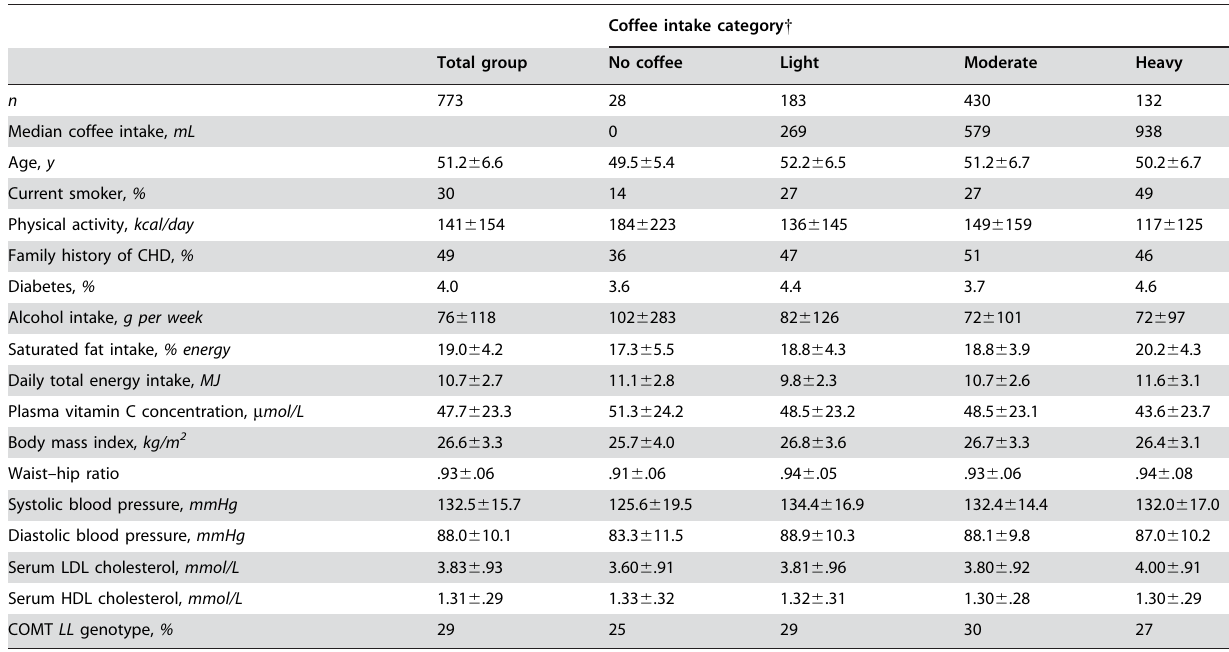
Table 1. Characteristics of the study participants, according to their average daily consumption of coffee.* .. ... .... ... ... .... ... ... .... ... ... .... ... ... .... ... ... .... ... ... .... ... ... .... ... ... .... ... ... .... ... ... .... ... ... .... ... ... .... ... ... .... ... ... .